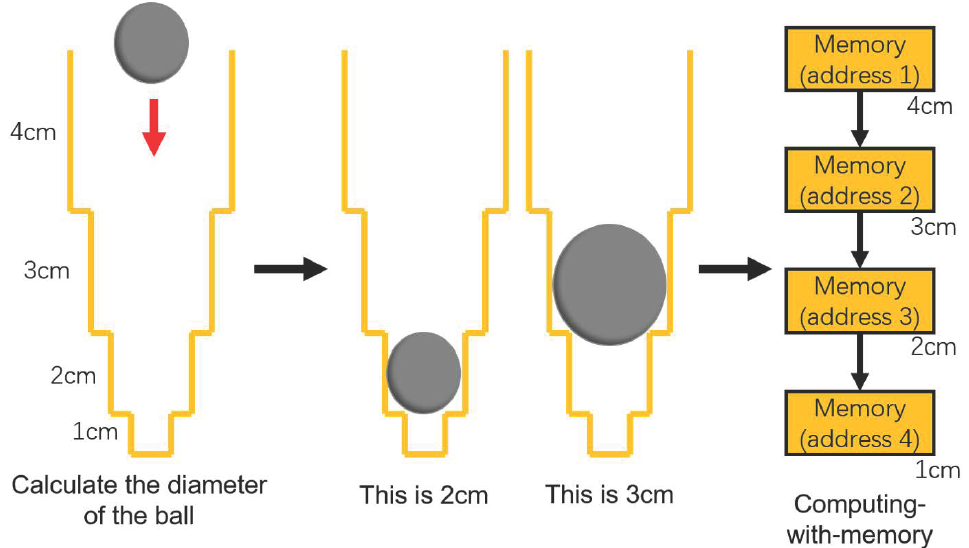
Figure 5. Example of using a container to calculate the diameter of a ball based on the Memory-Centric Computing